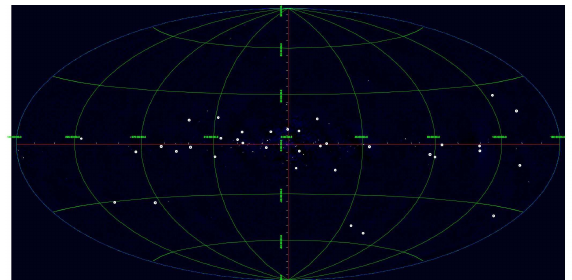
Figure 1: Distribution of CVs (white filled circles) in the 20-100 keV sky imaged by